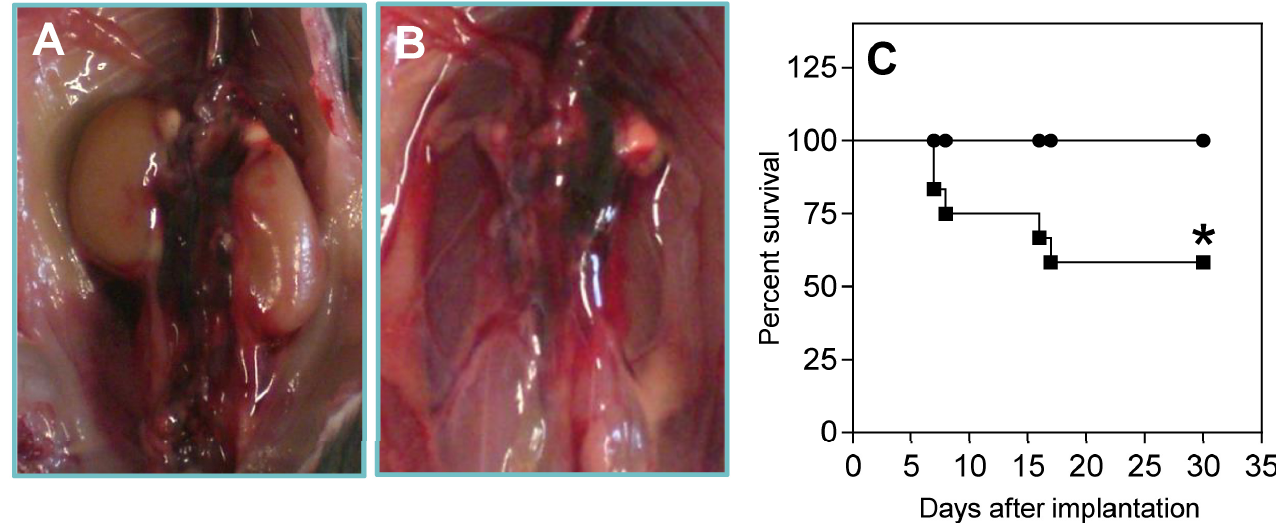
Fig 1. Survival curve of angiotensin II treated LDLr -/- and LDLr -/- CD1d -/- mice. Osmotic pumps filled with Ang II were implanted in LDLr -/- ( ■ , n = 12) and LDLr -/- CD1d -/- ( ● , n = 11) which were fed a Western-type of diet for 1 week. After implantation, LDLr -/- mice started to die due to rupture of the abdominal aorta (A and B). Percent survival per group is depicted (C). Statistical analysis was performed using the Mantel-Cox test. (cid:3) P < 0.05.